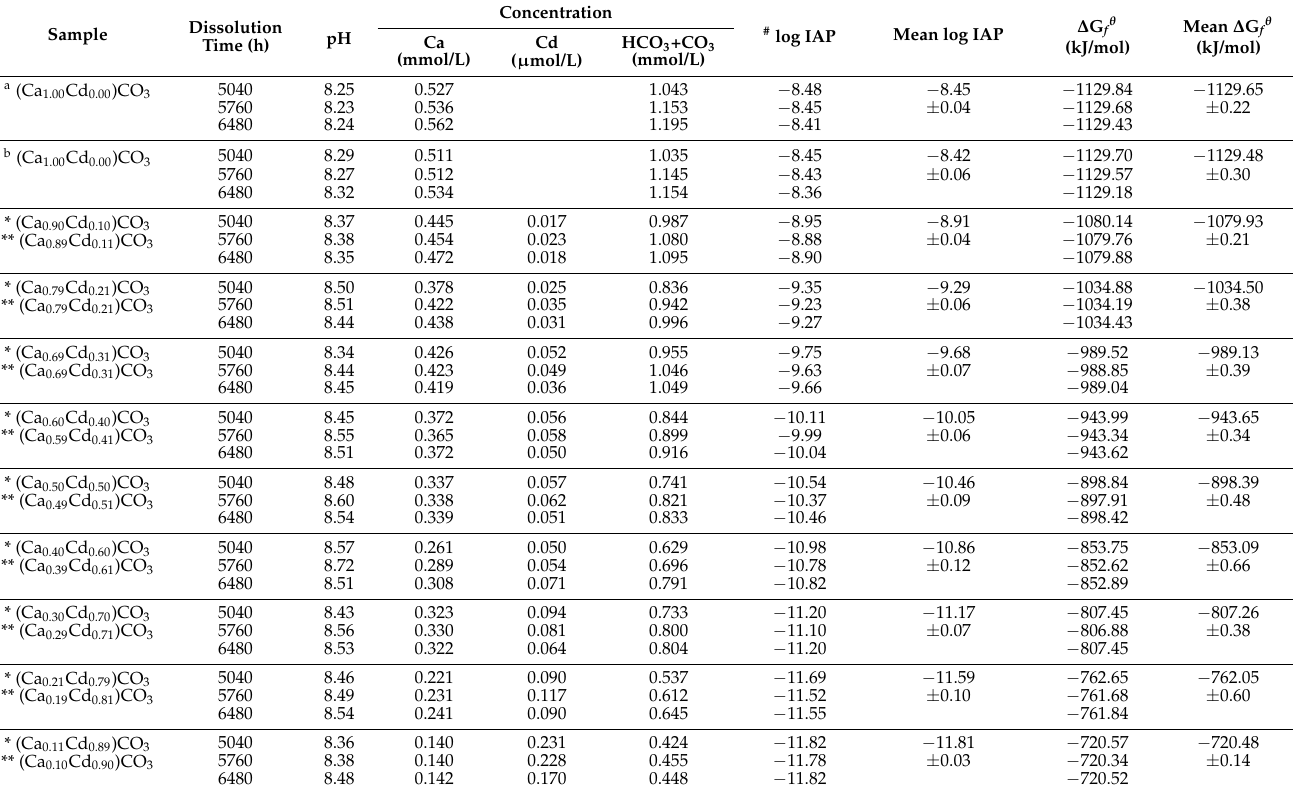
Table 2. Analytical data and solubility for the calcite–otavite solid solutions [(Ca 1 − x Cd x )CO 3 ] in the N 2 -degassed water at 25 ◦